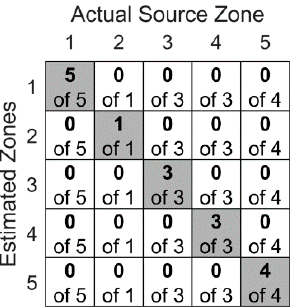
Figure 18. Confusion matrix of the convolutional neural network for the first experimental scenario. Localization zone here is the closest rivet to the AE source.